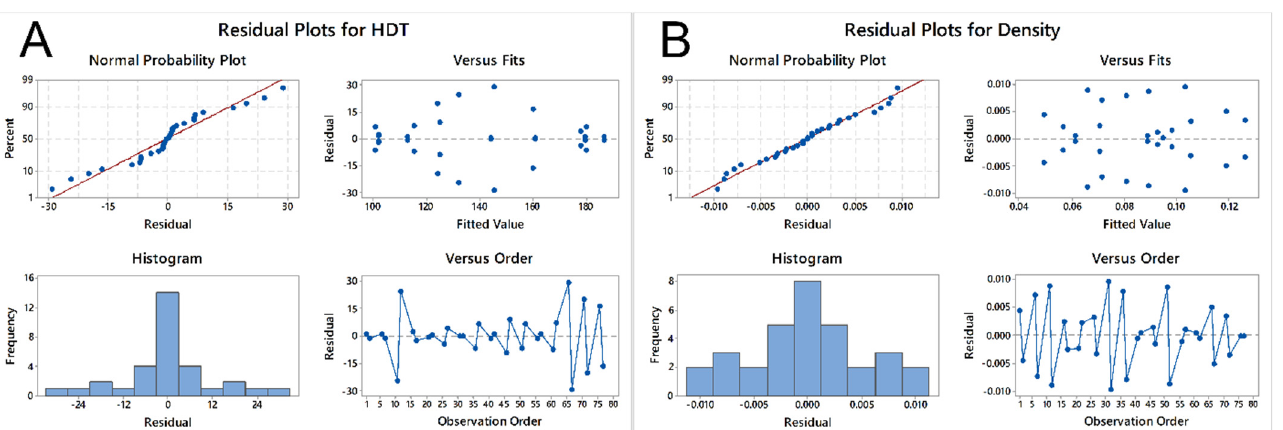
Figure 2. Residual plots for ( A ) tensile and ( B ) flexural modulus.